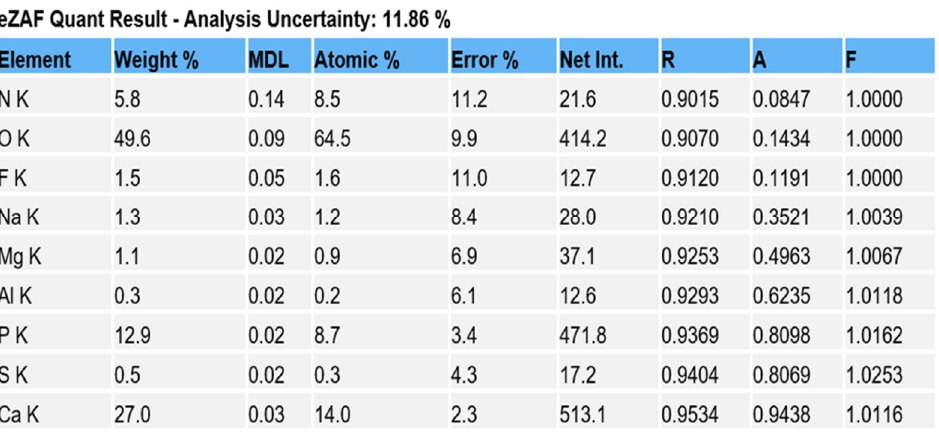
Figure 14. Data generated for the elements of interest, expressed as Weight % and Atomic %. Note the analysis uncertainty of 11.86%. Compared to data in Figure 13, there are decreases in Weight % and Atomic % or N, F, Na, and S and increases in Mg, P, and Ca. Oxygen was nearly equal in both specimens (49.1 for SRP only vs. 49.6 for SRP + EDTA).